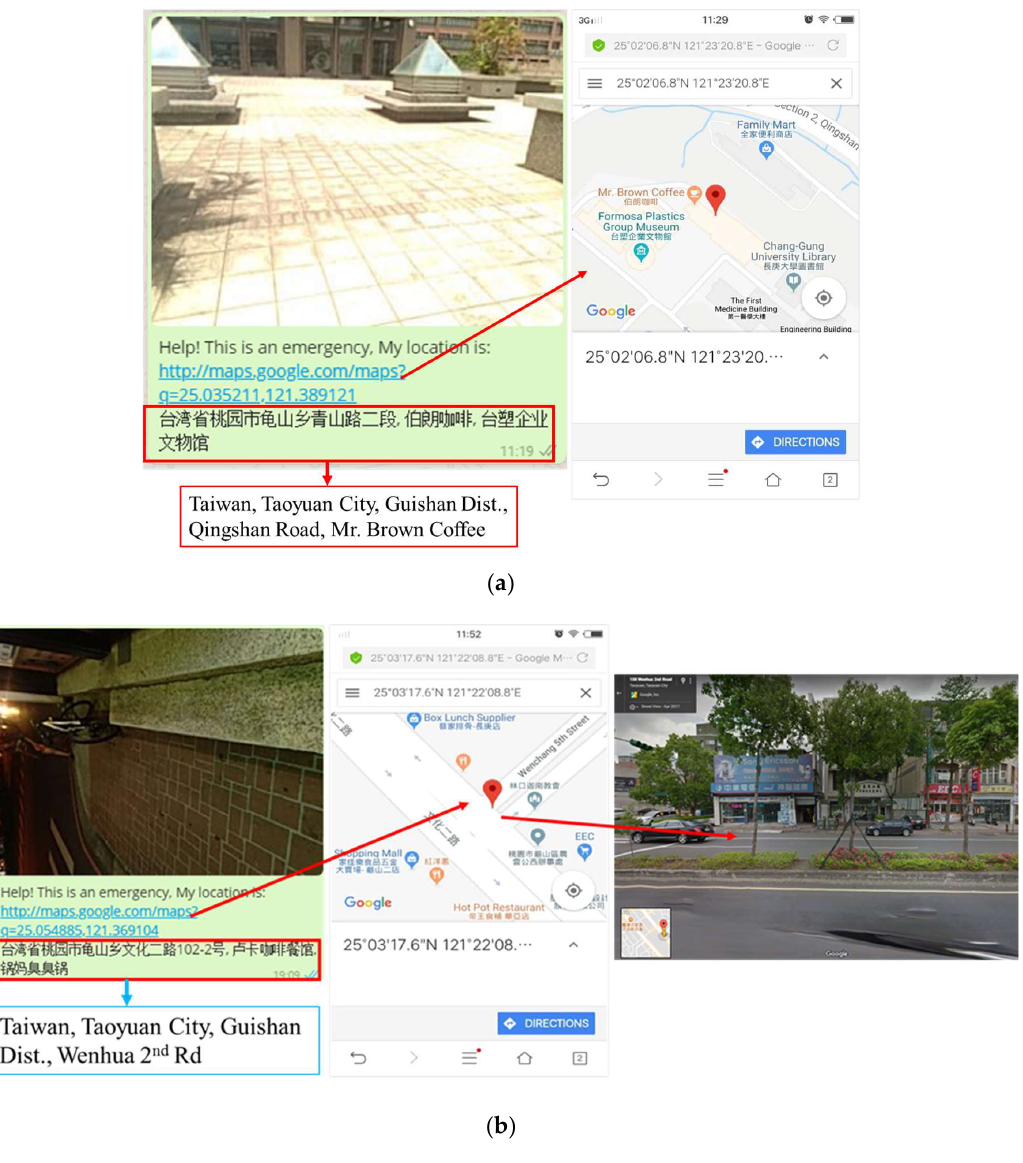
Figure 10. APP showing a shared picture with location addresses: ( a ) Mr. Brown Coffee, Chang Gung University; ( b ) in front of a cell phone shop at Wenhua 2nd road, Taoyuan.